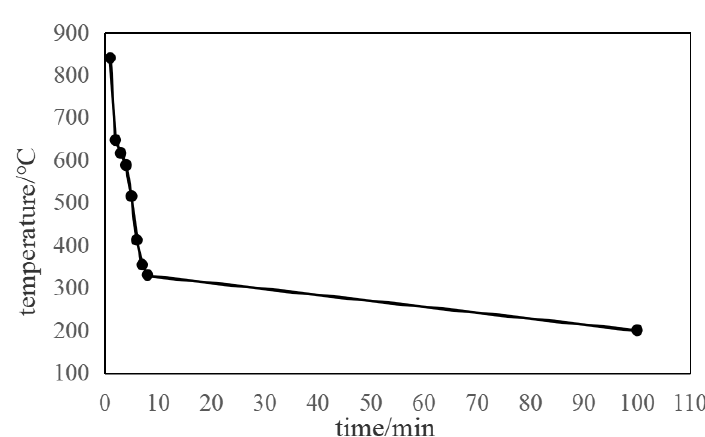
Figure 2. Sample size.